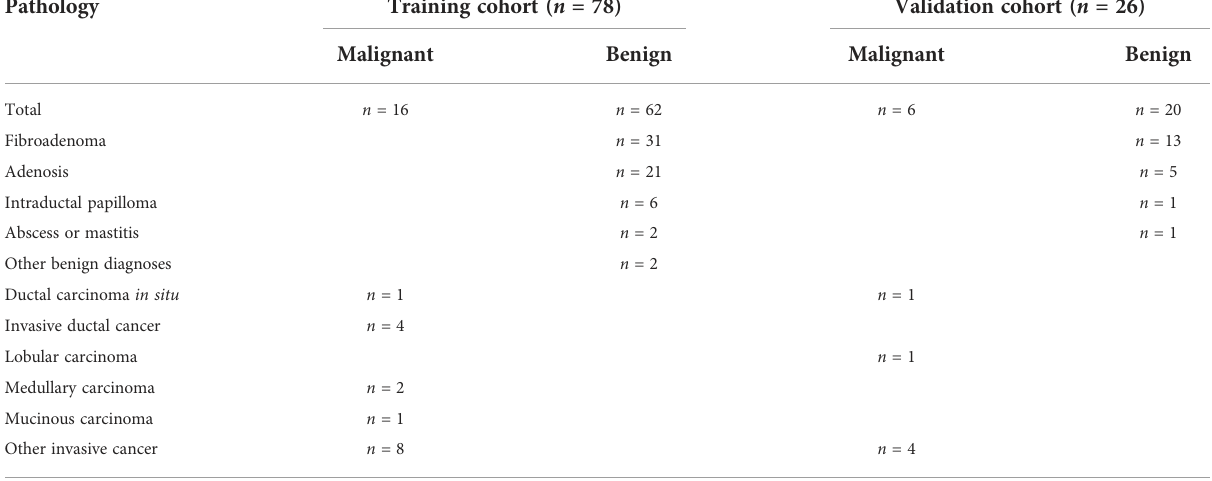
TABLE 1 Pathological diagnosis of 104 category BI-RADS 4 breast